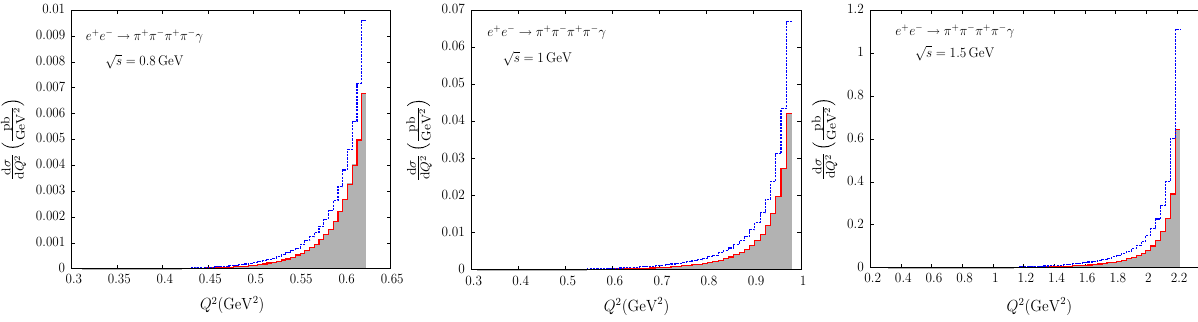
with the corresponding LO cross sections calculated in the HLS model defined by the Feynman rules of Figs. 7, 8 and 9 with fixed couplings. The fixed coupling cross sections receive contribution from 26 Feynman diagrams. They are plotted with dotted lines.